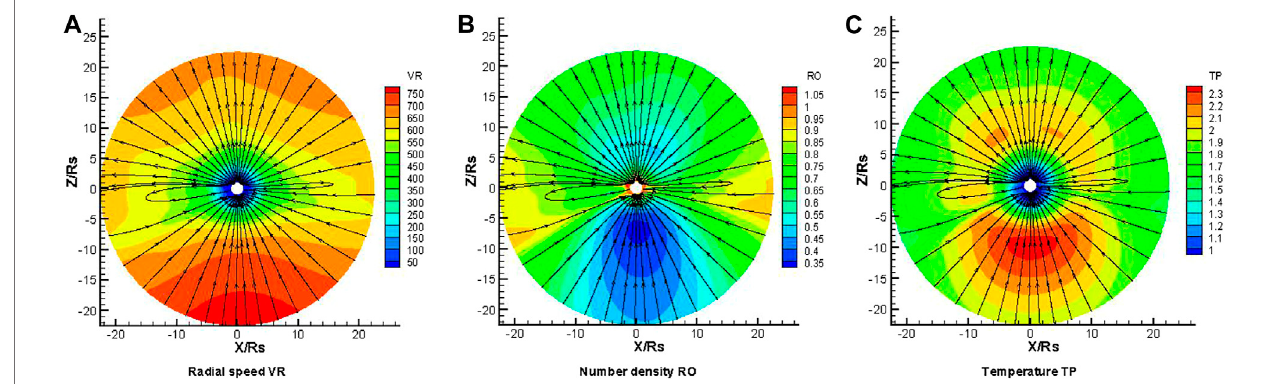
FIGURE 2| The distribution of the radial speed VR (km/s) (A) , density RO × 10 8 (/cm 3 ) (B) and temperature TP × 10 6 (K) (C) on themeridional plane of Φ (cid:2) 180 ° – 0 ° from 1 to 22.5R s , deduced from model B. The streamline represents the magnetic fi eld lines.